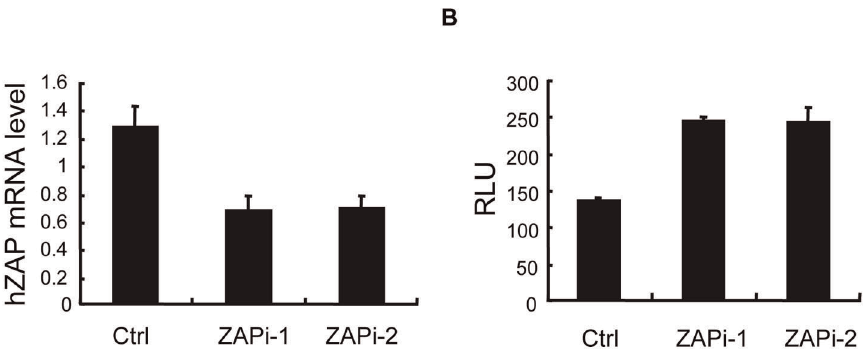
Figure 2. Downregulation of endogenous hZAP enhances XMRV-luc expression. HOS cells were transfected with control siRNA (Ctrl) or siRNAs directed against hZAP (ZAPi-1 and ZAPi-2), followed by infection with XMRV-luc for 5 h. At 48 h postinfection, cells were lysed. (A) Endogenous hZAP mRNA levels were measured by real-time PCR. (B) Luciferase activity was measured and presented as relative light units (RLU). Data presented are means 6 SD of three measurements.